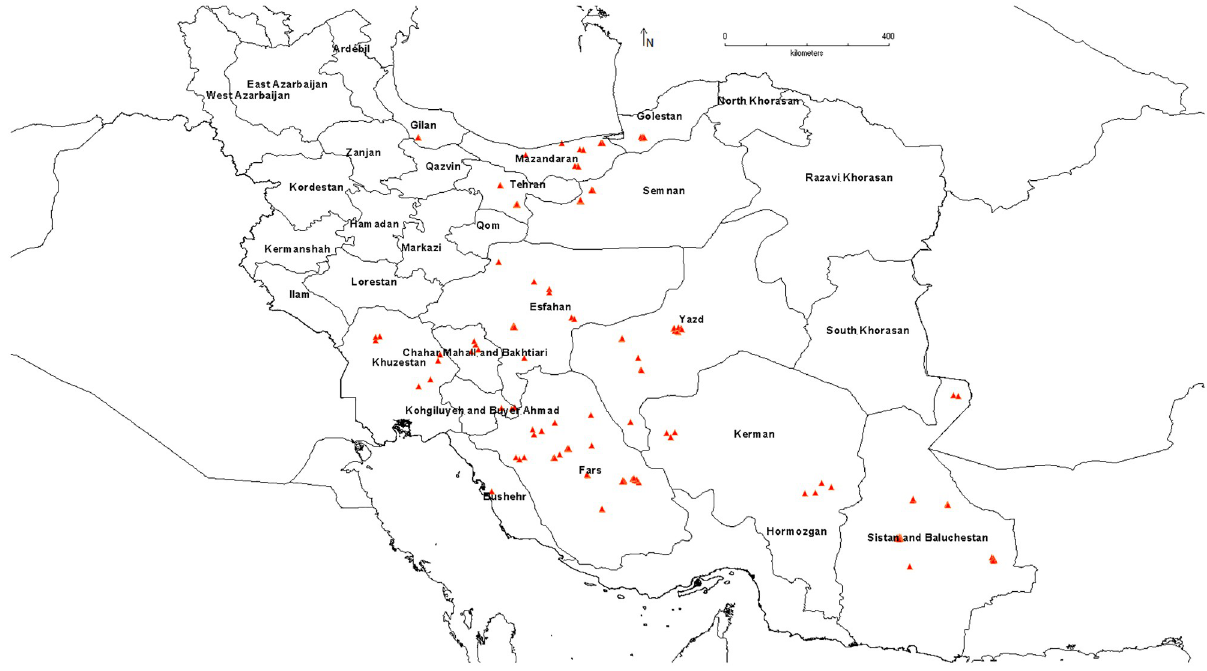
Fig 1. Locations of 152 distribution points of the studied pomegranate genotypes in Iran.